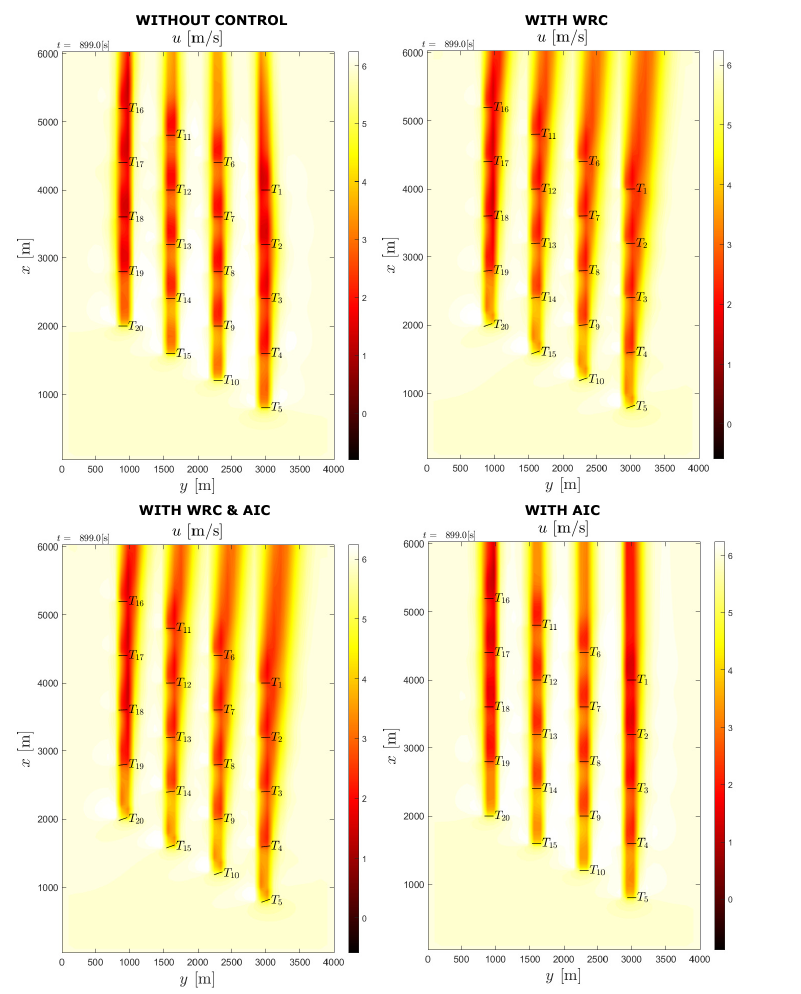
Figure 14. Flow field diagram from WFSim for real-life wind farm at 6 m/s mean wind speed. In Figure 15, the corresponding power output from each turbine in the wind farm is presented when WRC is used in comparison to when WRC is not used. It is clear from the figure that the upstream turbine power has been reduced due to WRC; however, at the same time, considerable power improvement is observed by the downstream turbine as expected. Thus, the total wind farm power output production is